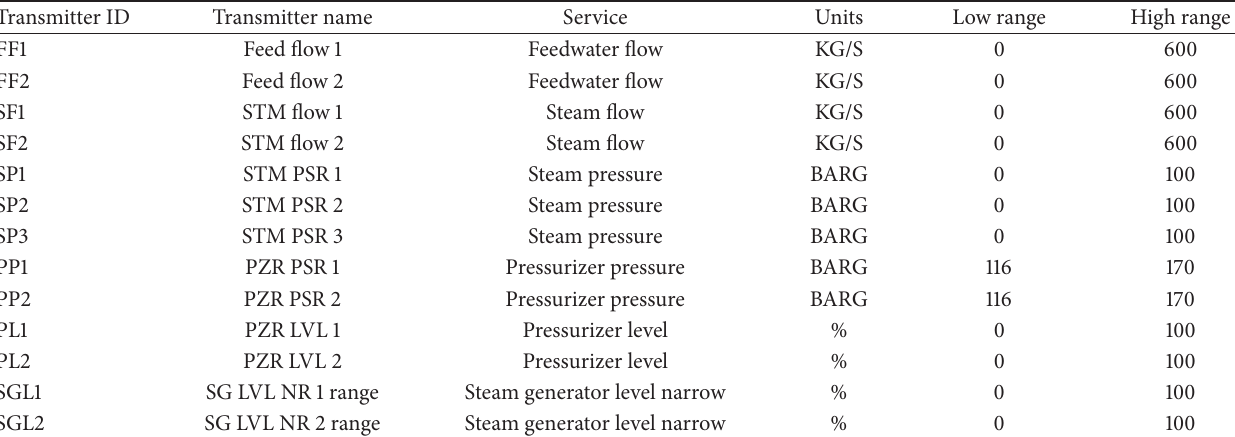
Table 1: List of NPP